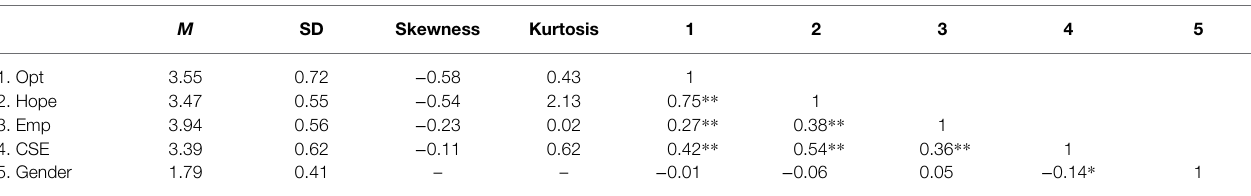
TABLE 1 | Mean (M), standard deviation (SD), skewness, and kurtosis of all variables as their bivariate Pearson intercorrelations ( N = 330). M SD Skewness